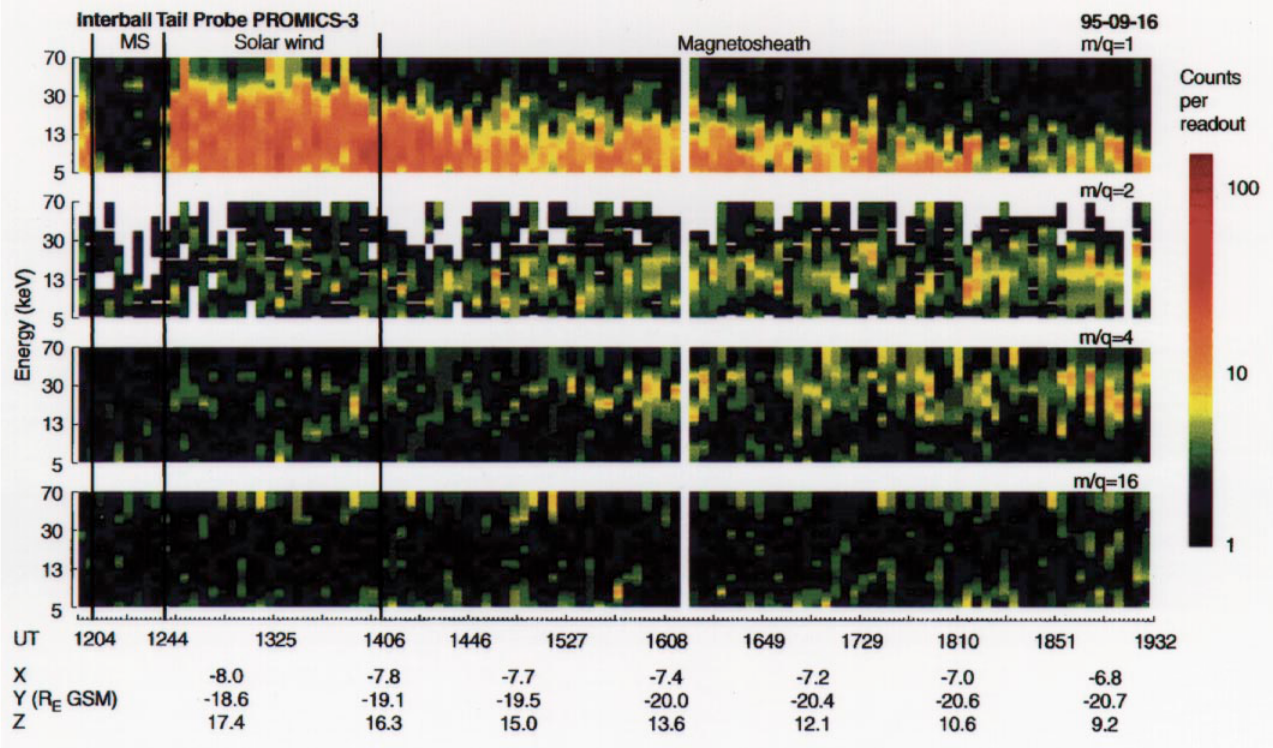
Fig. 8. Ions of different species measured on 16 September 1995 in the dawnside magnetosheath just inside the bow shock had energies proportional to the mass per unit